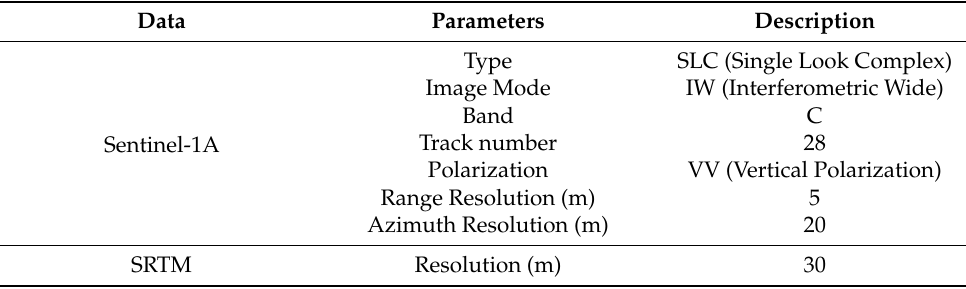
Table 2. The specific information of collected Sentinel-1A images and SRTM data.